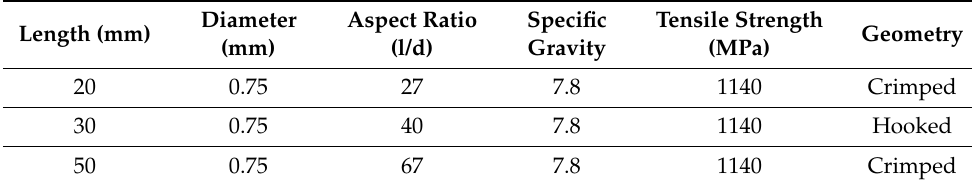
Table 4. Properties of steel fibers.